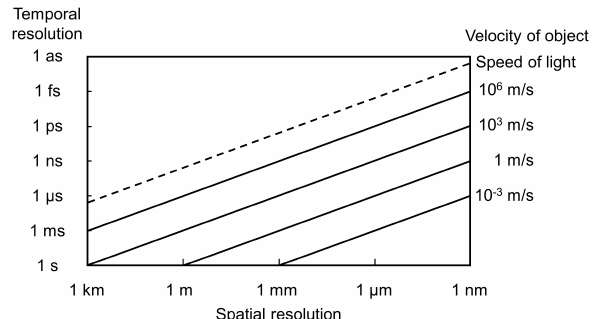
Fig. 2. Temporal resolution required as a function of spatial res- olution. As the spatial resolution becomes higher, the temporal resolution for imaging of a moving object needs to be finer, even at a constant moving